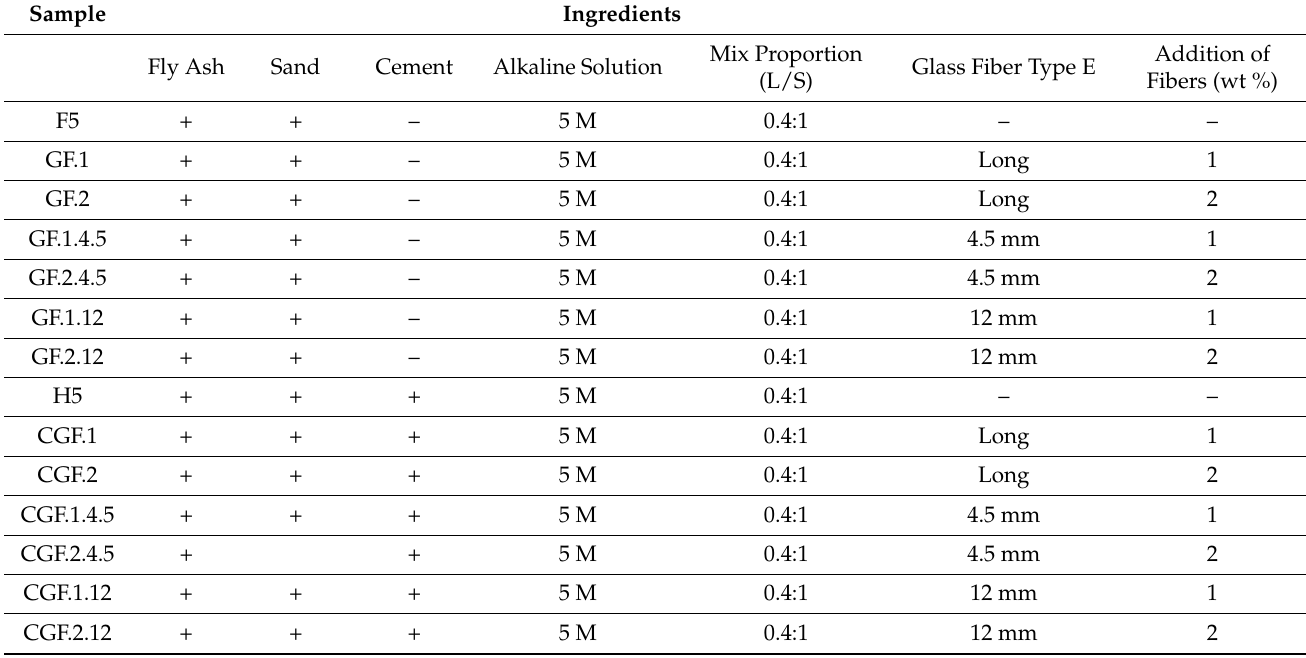
Table 4. Composition of prepared geopolymer composites reinforced with glass fiber type E.